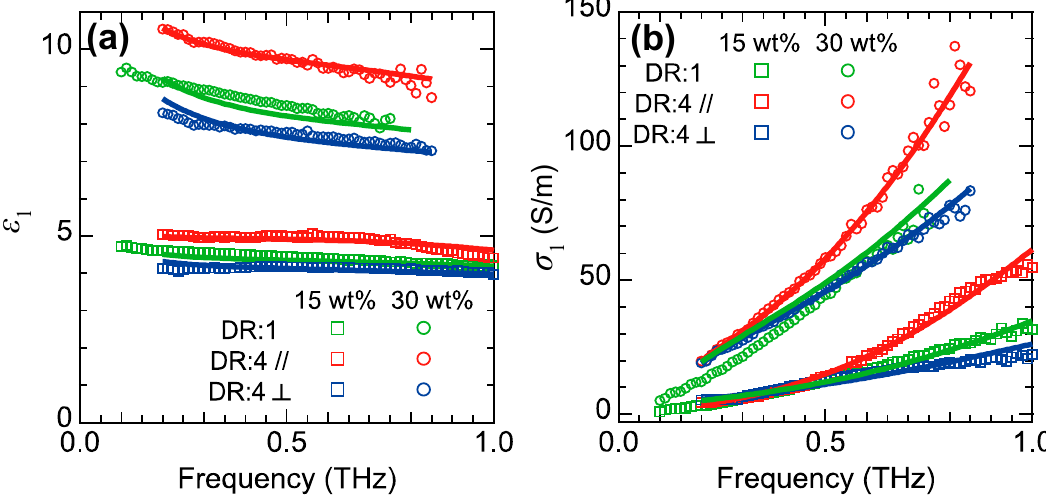
Figure 8. The real part of ( a ) the dielectric function and ( b ) the conductivity for the SBR samples with CB amounts of 15 (squares) and 30 wt % (circles) at DR = 1 (green) and DR = 4 (red and blue). The red and blue symbols correspond to the data parallel and perpendicular to the stretching direction, respectively. The solid curves represent the calculation results. Reproduced from Ref. [43] with the permission of AIP publishing (License Number: 4457780180478).